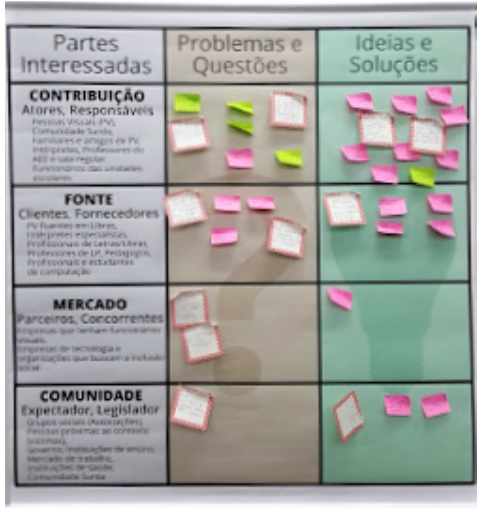
Fig. 4. Evaluation Frame of the 2nd SPW (A6)